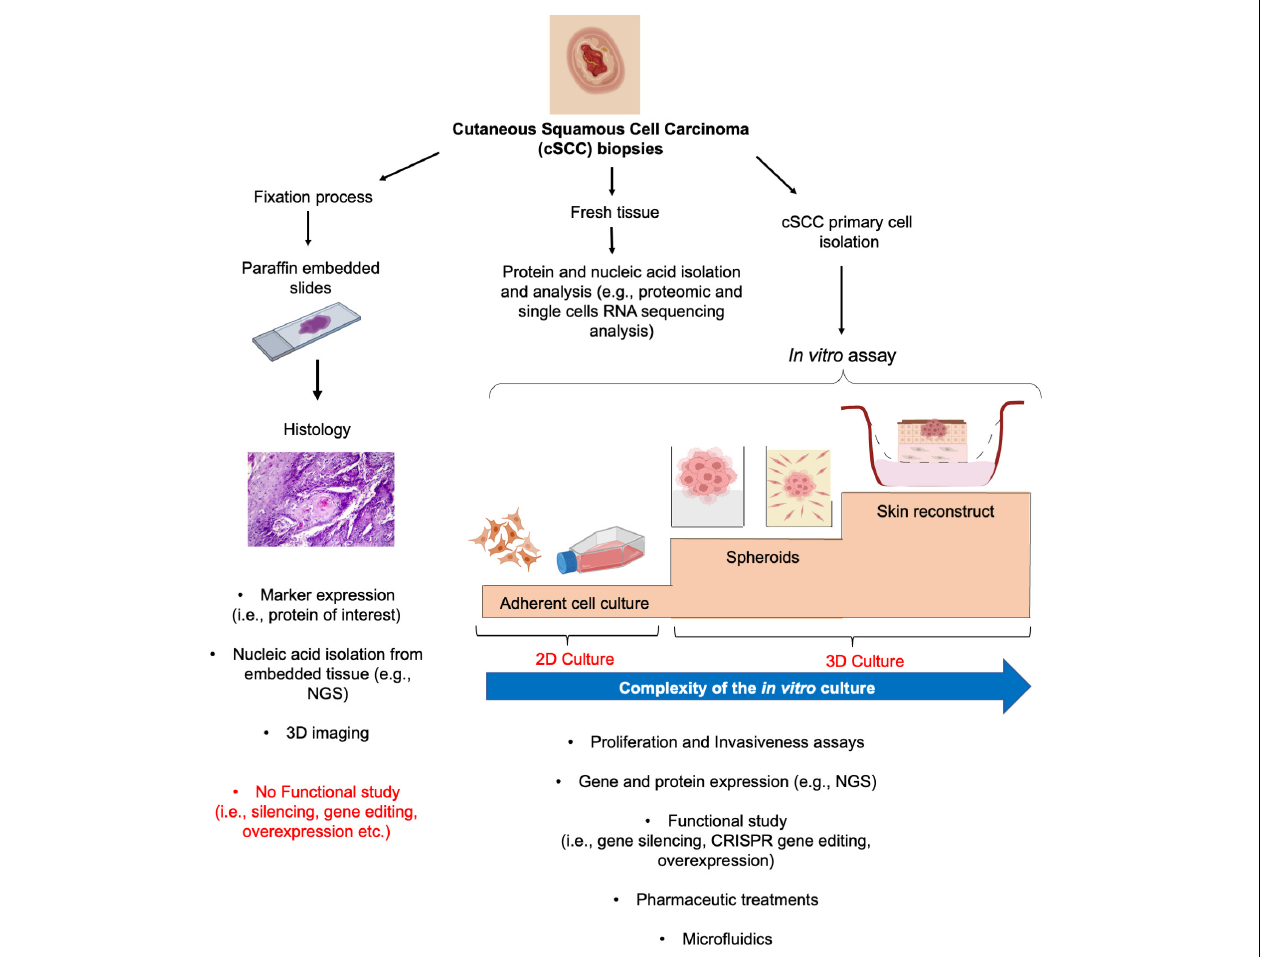
FIGURE 2 | From histology to 2D and 3D culture methods for cSCC study. From fresh biopsy, histological evaluation provides the basis for subsequent gene and protein expression analysis (left panel) . Similarly, fresh tissue could undergo to different procedures for protein or gene expression analysis (middle panel) . The isolation and culture of the cSCC primary cells allows the functional characterization of the tumor by mean of 2D and more sophisticated 3D culture systems, such as spheroids and skin reconstruct (right panel) .